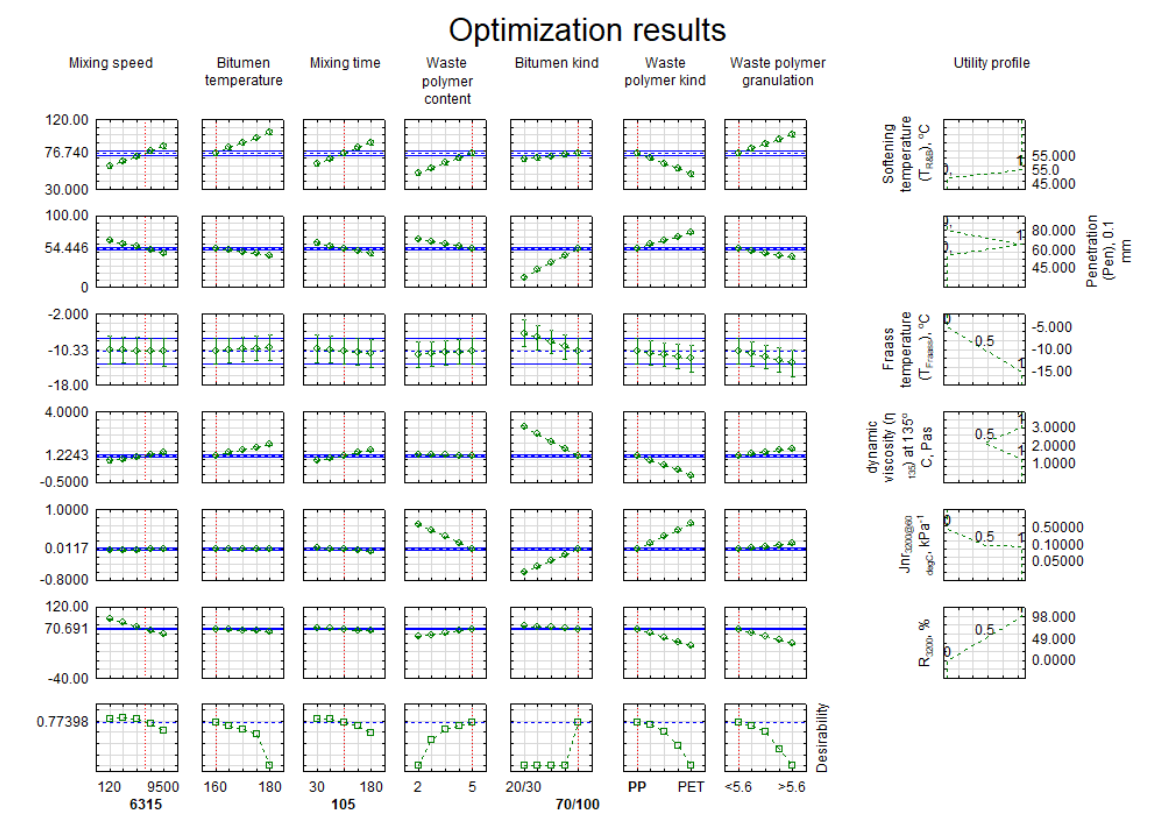
Figure 13. Results of the search for the optimal bitumen and plastomer mixing solution.